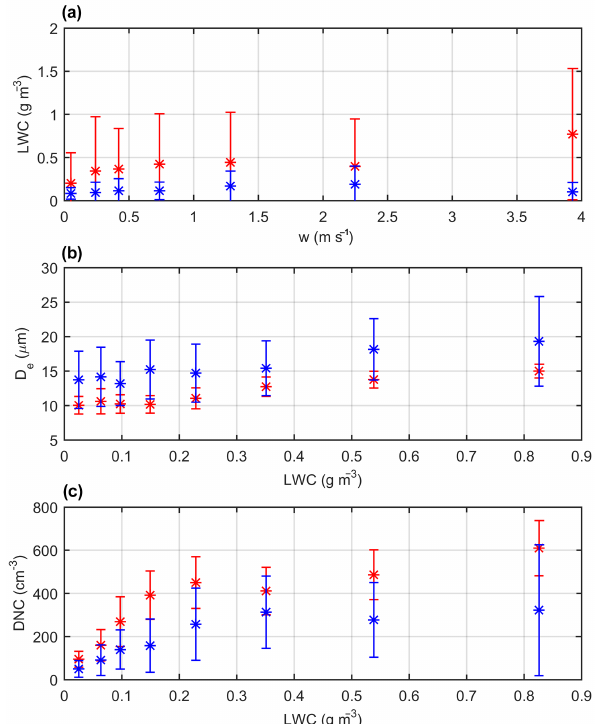
Figure 7. (a) Mean LWC values for different log-spaced w intervals and (b) mean D e and (c) DNC for log-spaced LWC intervals. Error bars are the standard deviation for each interval. Blue points indi- cate background measurements, while red ones are relative to the polluted ones. The points are located at the middle of the respec- tive bin intervals. Those results are limited to the first 1000m of the